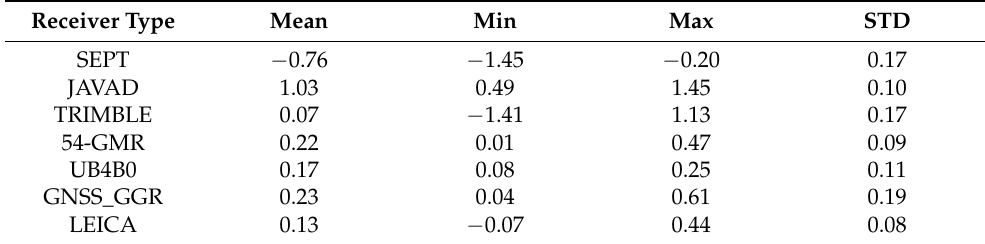
Figure 13. Mean differences and STDs of receiver C2I-C6I DCB estimates between BDS2+BDS3 and BDS2-only solutions. The receivers are sorted by receiver type. Table 8. Consistency of receiver DCBs between BDS2-only and BDS2+BDS3 solutions during the test period (unit: ns).